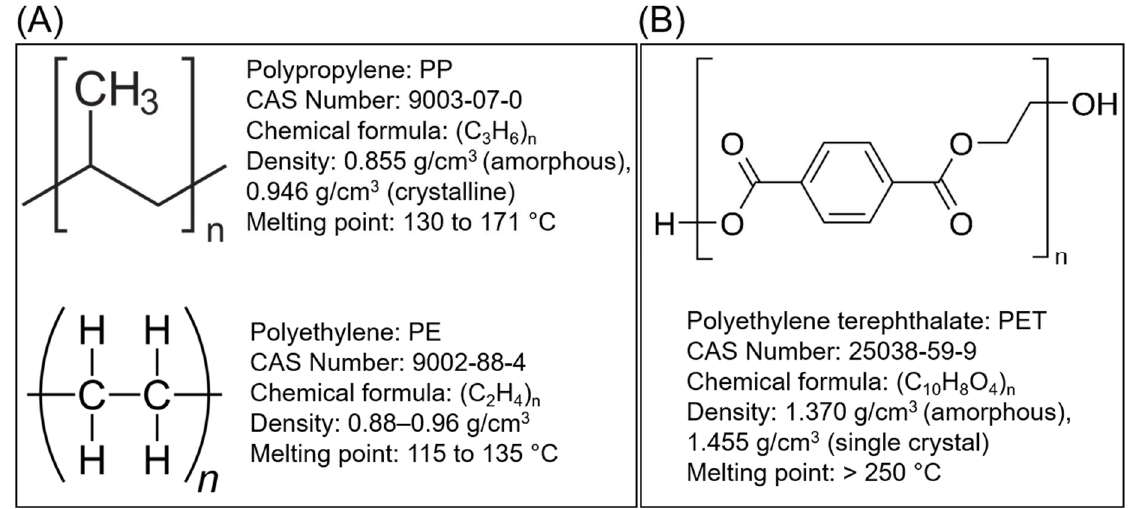
Figure 2. Structural and physicochemical characteristics; ( A ) category of non-hydrolysable plastics examples with a C–C backbone, and ( B ) category of hydrolysable plastics examples with a C–O backbone.